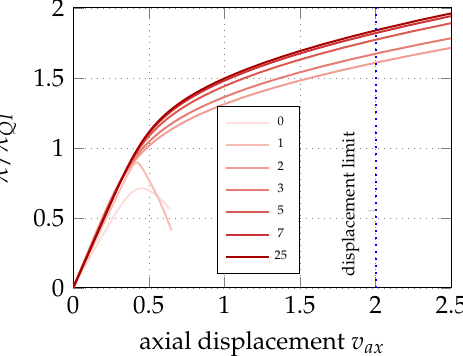
Figure 4. Load–displacement paths after different GCMMA iterations ( 0,1, . . . 25 ) at stage 1 with a grid of 9 9 material control points. ×